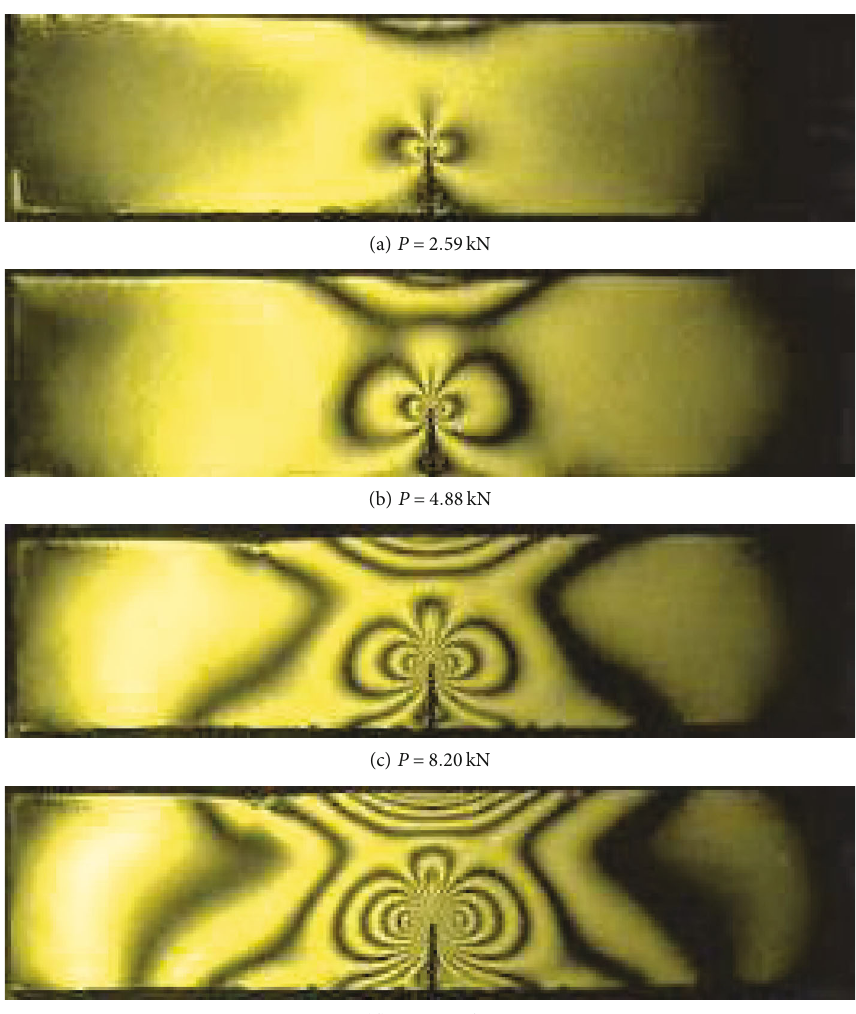
Figure 6: Crack propagation displayed by coatings (specimen